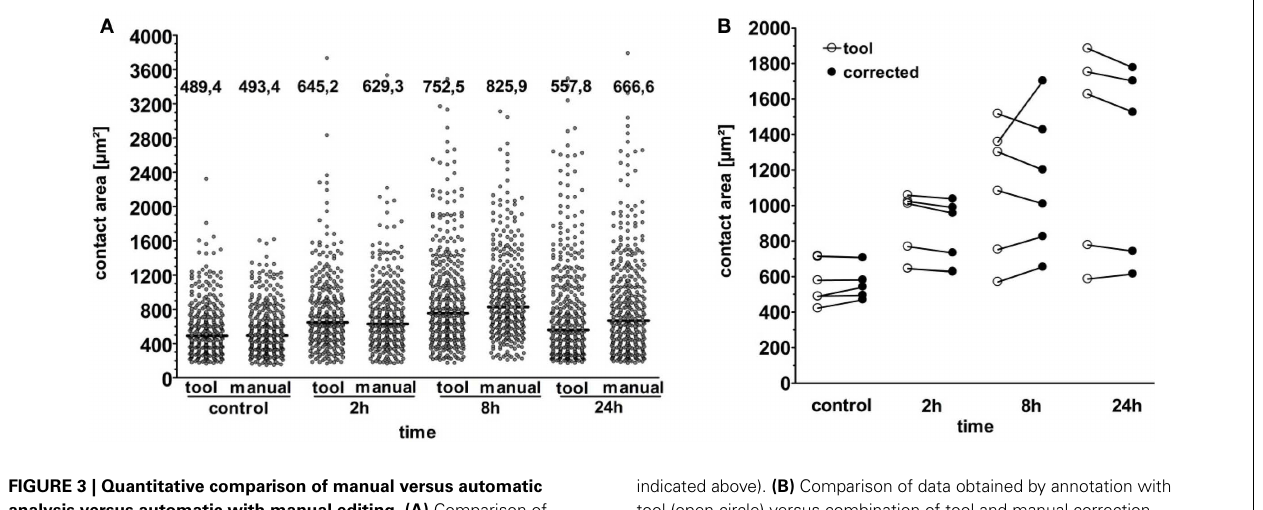
FIGURE 3 | Quantitative comparison of manual versus automatic analysis versus automatic with manual editing. (A) Comparison of cell contact area measured automatically versus manual annotation. Data are from one experiment. Each dot represents one cell. Black bars within the scatter plot show median contact area (numerical value